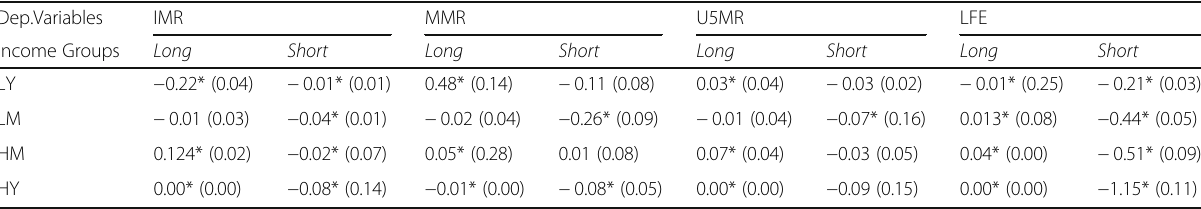
Table 3 Mean group estimation ARDL model Dep.Variables